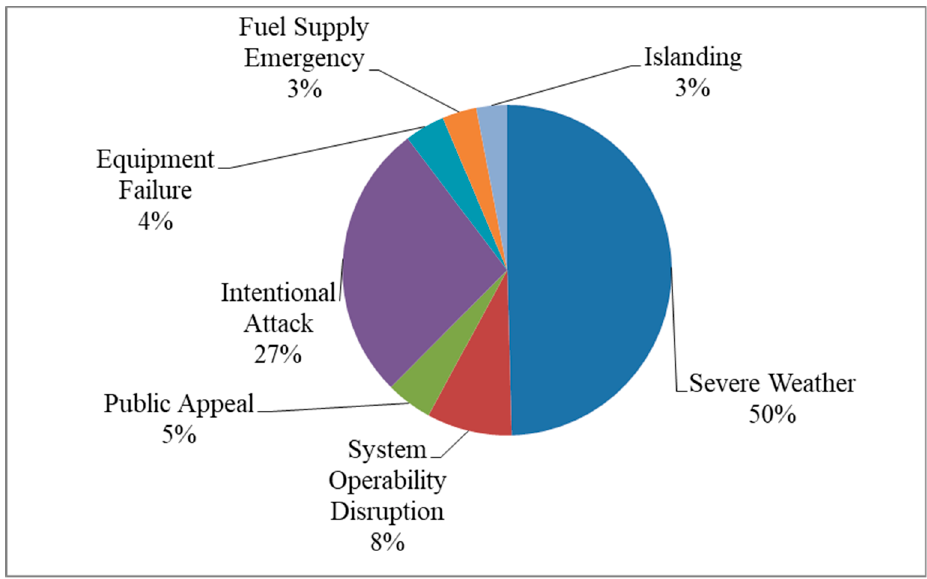
Figure 1. Frequency of different events that caused power outages as percentages [29].